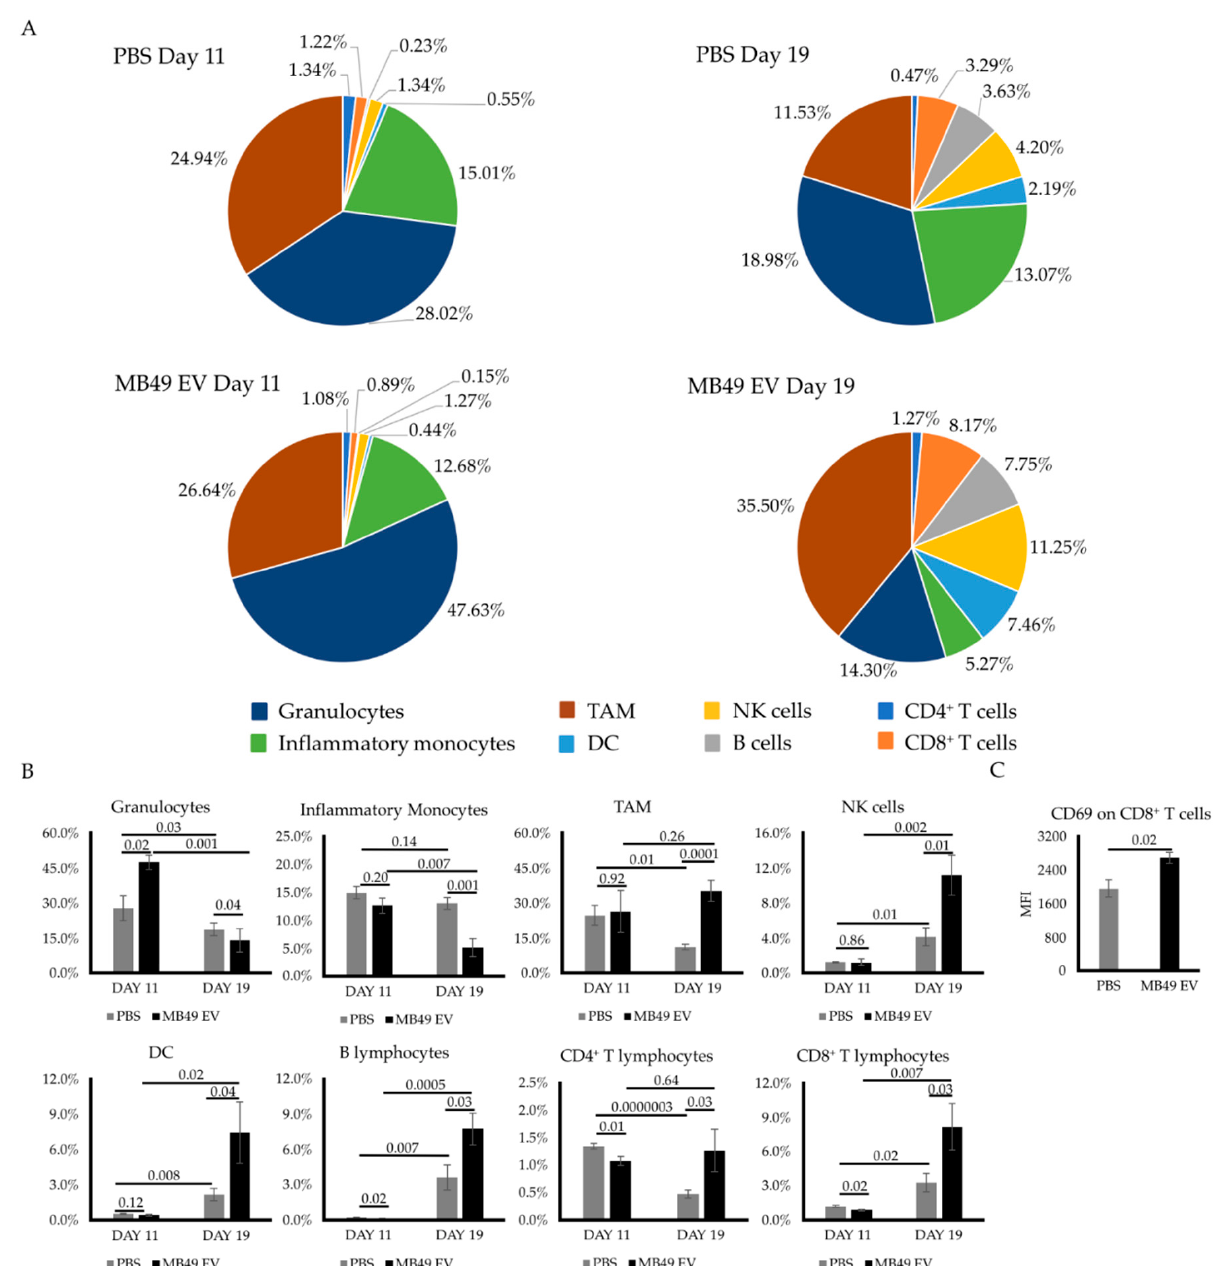
Figure 3. MB49 EV-driven tumor growth prevention is mediated by an immune cell-enriched TME. ( A ) Pie charts represent the percentage of tumor-infiltrated immune cell subpopulations at different time points in control PBS- and EV-primed tumors. ( B ) Bar graphs comparing averaged percentages of infiltrated immune cell subpopulations at day 11 and day 19 in control mice and MB49-EV-primed mice. Identified immune cells are shown as follows: granulocytes, inflammatory monocytes, tumor-associated macrophages, natural killer cells, dendritic cells, B lymphocytes, CD4 + T lymphocytes and CD8 + T lymphocytes. ( C ) Activation level of infiltrated CD8 + T lymphocytes as indicated by their surface CD69 protein expression (mean fluorescence intensity) at day 19. The n number is 7 on each group. Error bars show standard error. Statistical significance was calculated by independent Student t test and two-way ANOVA with Tukey’s multiple comparisons test.